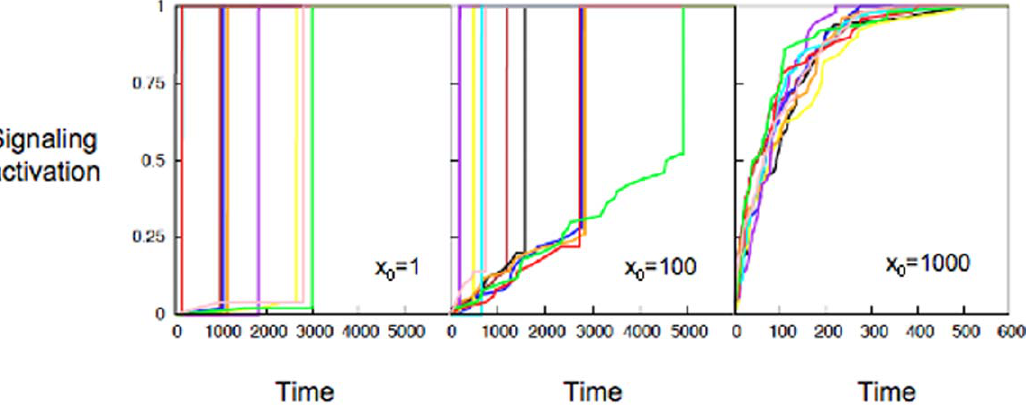
Figure 3. Switch from type B to type A signaling with increasing stimuli. Activation of x 3 molecules at the single cell level for weak: x 0 ~ 1 (left), intermediate: x 0 ~ 10 (middle), and strong: x 0 ~ 1000 (right) stimuli. x 3 activation is normalized by its maximum. Different colors correspond to different individual cells.